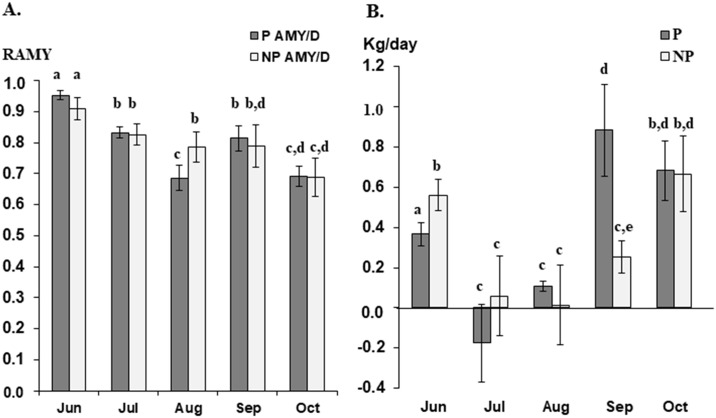
Physiological heat stress indicators recorded during HS and NHS conditions in both pregnant and non-pregnant lactating cows.(A) Relative average milk yield (RAMY) to May; (B) Average dairy gain (ADG). HS, Heat stress; NHS, Non-heat stress; P, Pregnancy; NP, Non-pregnancy. Different superscript letters indicate significant difference (P<0.05).